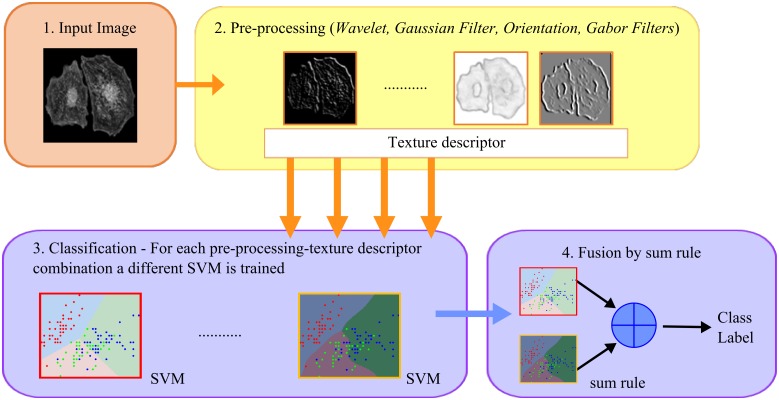
Flowchart of the preprocessing.